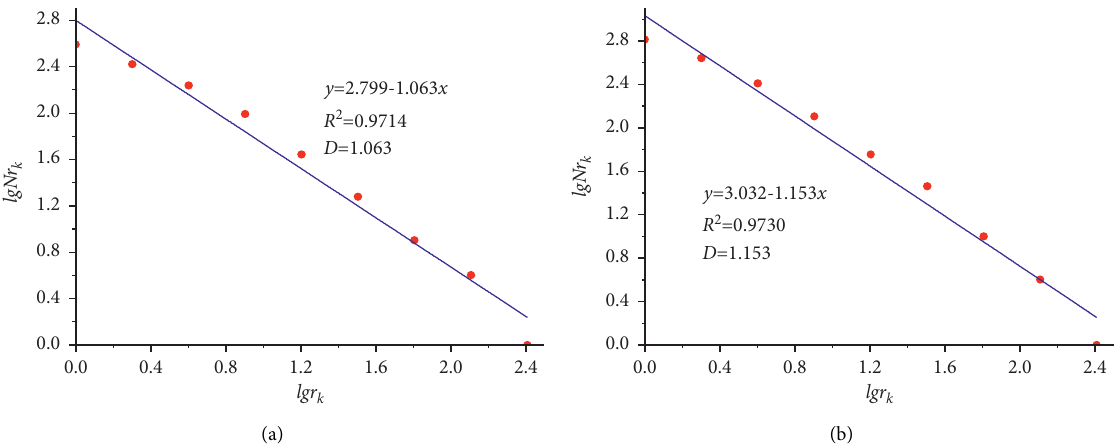
Figure 11: Calculation results of fractal dimension of the irregular particle (without